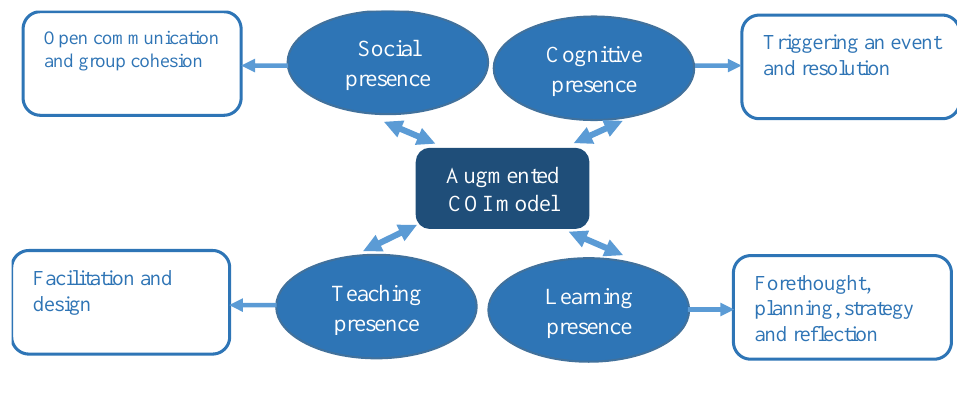
Augmented Community of Inquiry Model Adapted from Witthaus